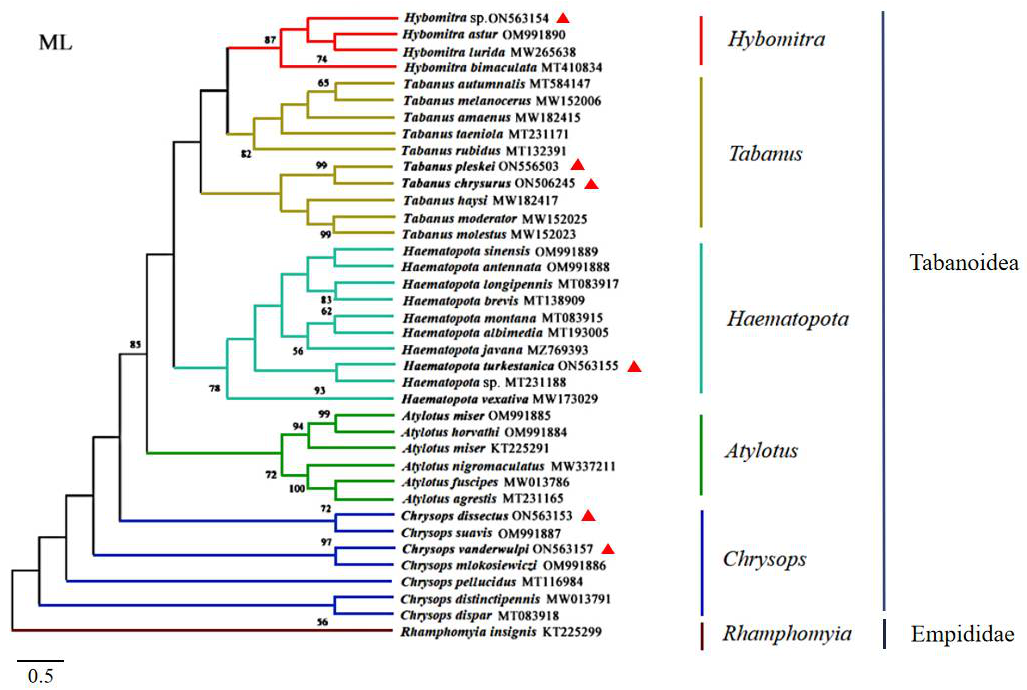
Figure 2. Phylogenetic reconstruction of 38 cox 1 sequences was performed using the maximum likelihood analysis. The species sequenced in this study are indicated with red triangles.